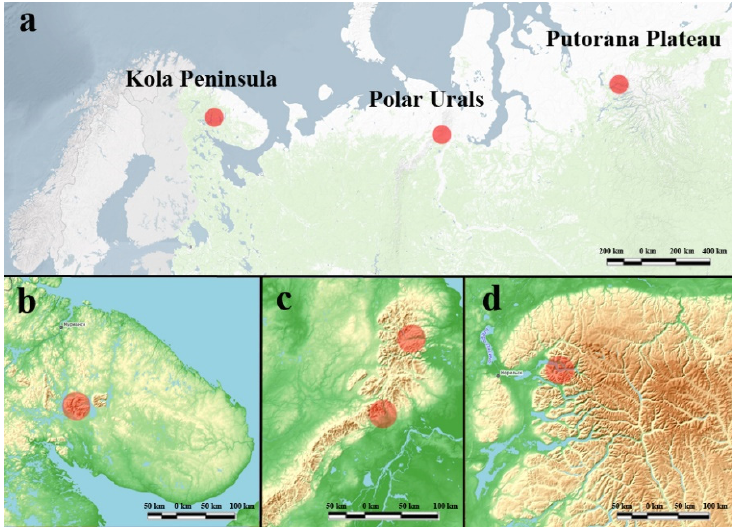
Figure 2. Study site locations at the north-western part of Eurasia (a) , Kolar Peninsula (b) , Polar Urals (c) , Putorana Plateau (d) . Table 1. General information on the target regions.